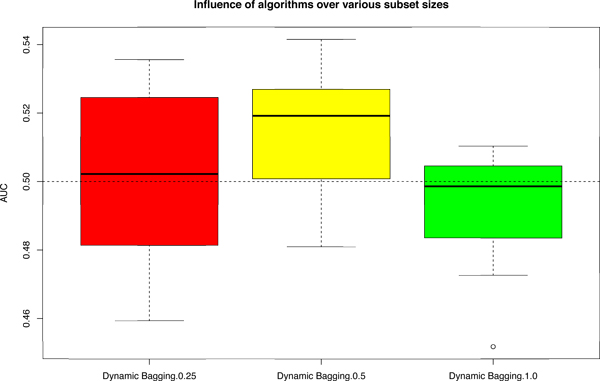
Boxplot of AUC on varying subset sizes under various scenarios (36) for data set I. Subset size here implies using a random subset of the given data during training phase. "Dynamic Bagging.0.25", "Dynamic Bagging.0.5" and "Dynamic Bagging.1.0" are the AUC achieved by applying dynamic bagging and using rank values with 25%, 50% and 100% of original given data for training.